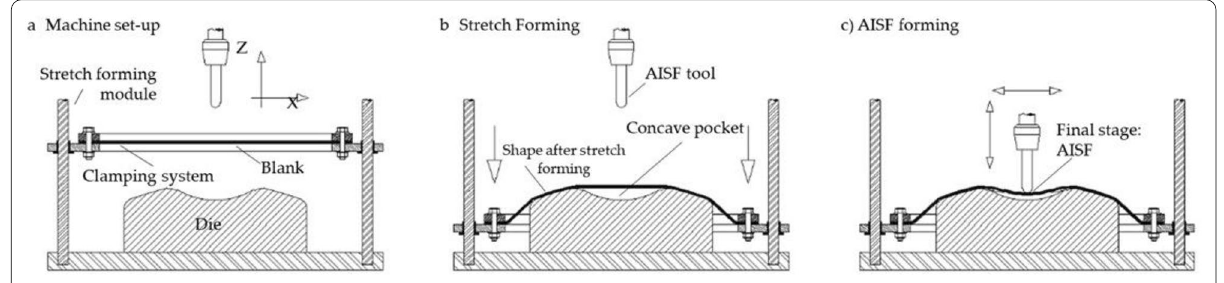
Figure 3 Principle of the process combination